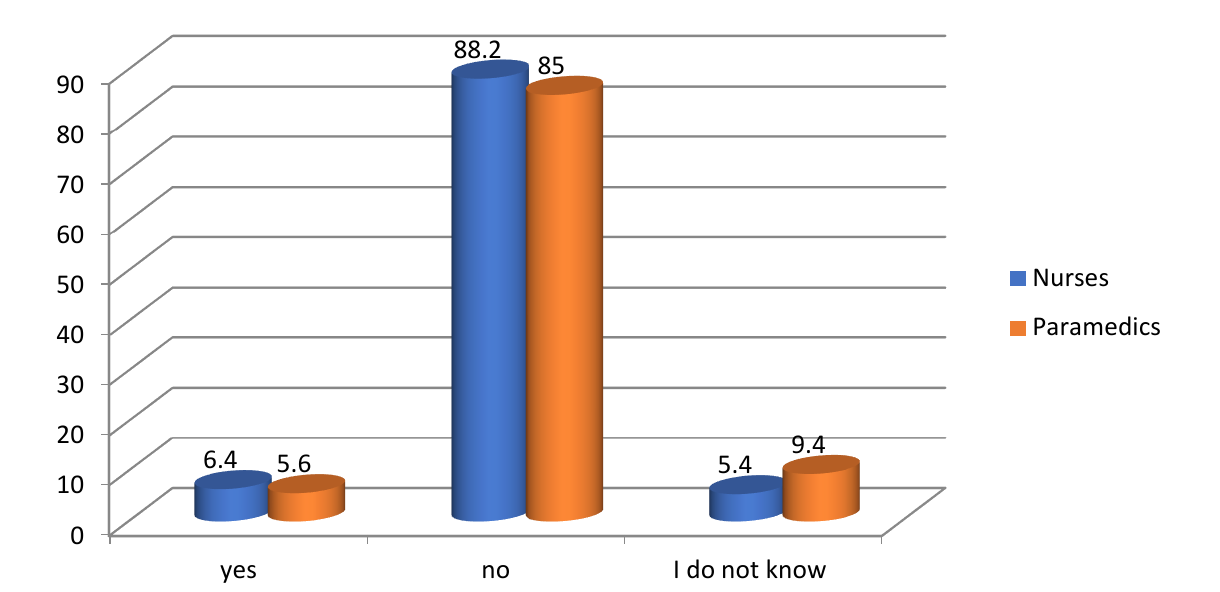
Figure 1. Respondents’ opinions on the adequacy of salary in relation to the work they perform. Psychological help is important for people whose professions are stressful and responsible as it helps to relieve stress. However, in both groups of respondents, in general, only 7.4% of the respondents used professional psychological assistance. This is a small percentage. The others unanimously stated that they do not use the services of a psychologist (Figure 2).